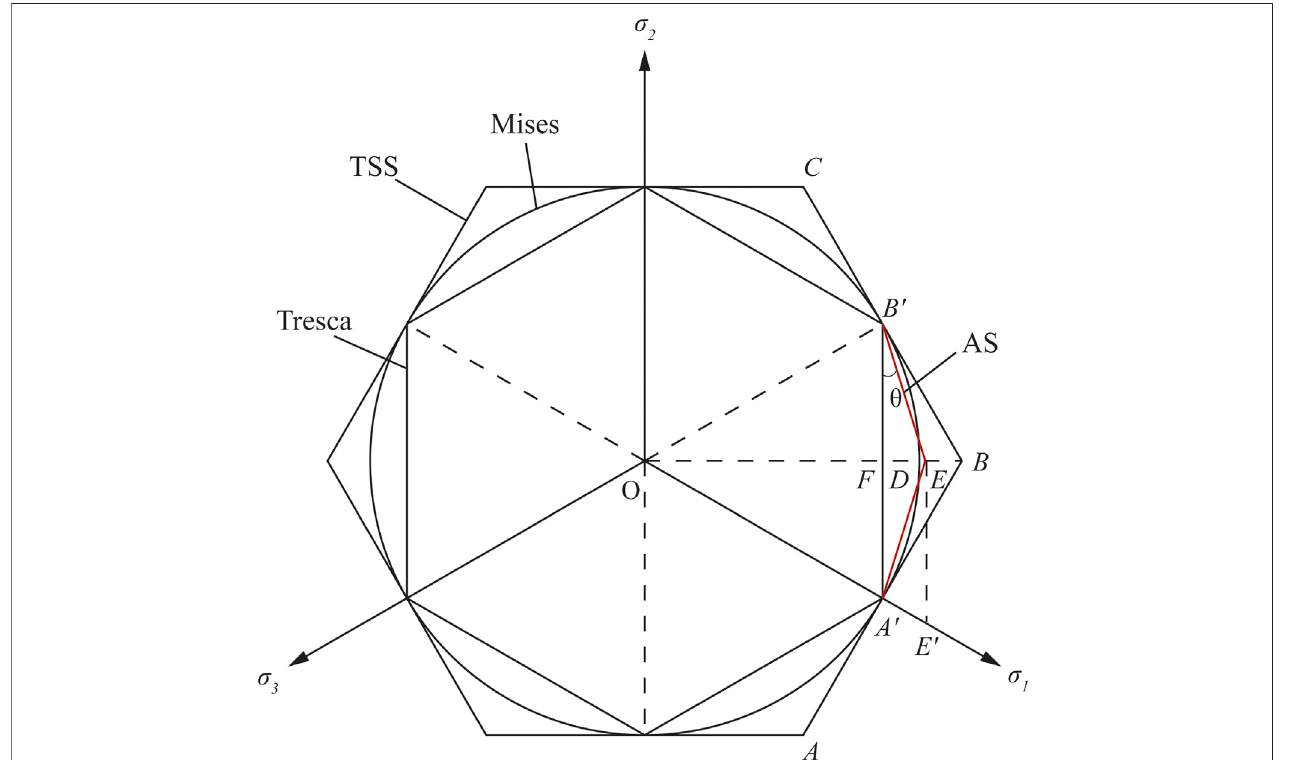
FIGURE 1 | Different loci on the π